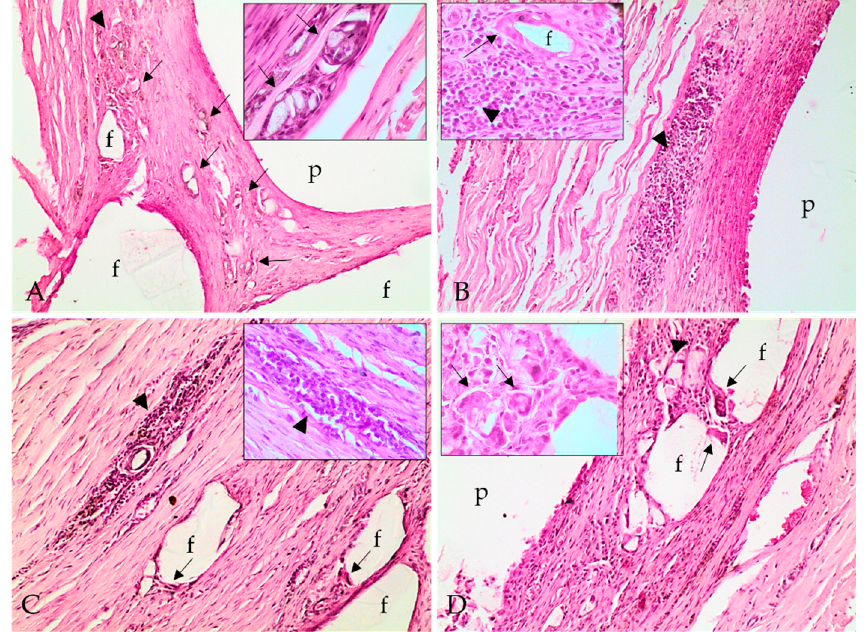
Figure 4. Photomicrographs of implant polymer sites with the polymer (p), lymphoplasmacytic inflammatory infiltrate (arrowhead), and epithelioid macrophages and multinucleated giant cells, with intracytoplasmic polymer material, thus characterizing polymer phagocytosis (arrows). ( A ) Inflammatory infiltrate and polymer phagocytosis at 24 weeks; ( B ) 28 weeks; ( C ) 34 weeks; and ( D ) 38 weeks. Hematoxylin and eosin stain; 100×. Inlet ( A , D ): multinucleated giant cells with intracytoplasmic fragments of polymer material, characterizing phagocytosis (arrows). Inlet ( B , C ): lymphoplasmacytic inflammatory infiltrate (arrowhead). Inlet ( C ): epithelioid macrophages (arrow) delimiting a polymer fragment (f). Hematoxylin and eosin stain; 400×.